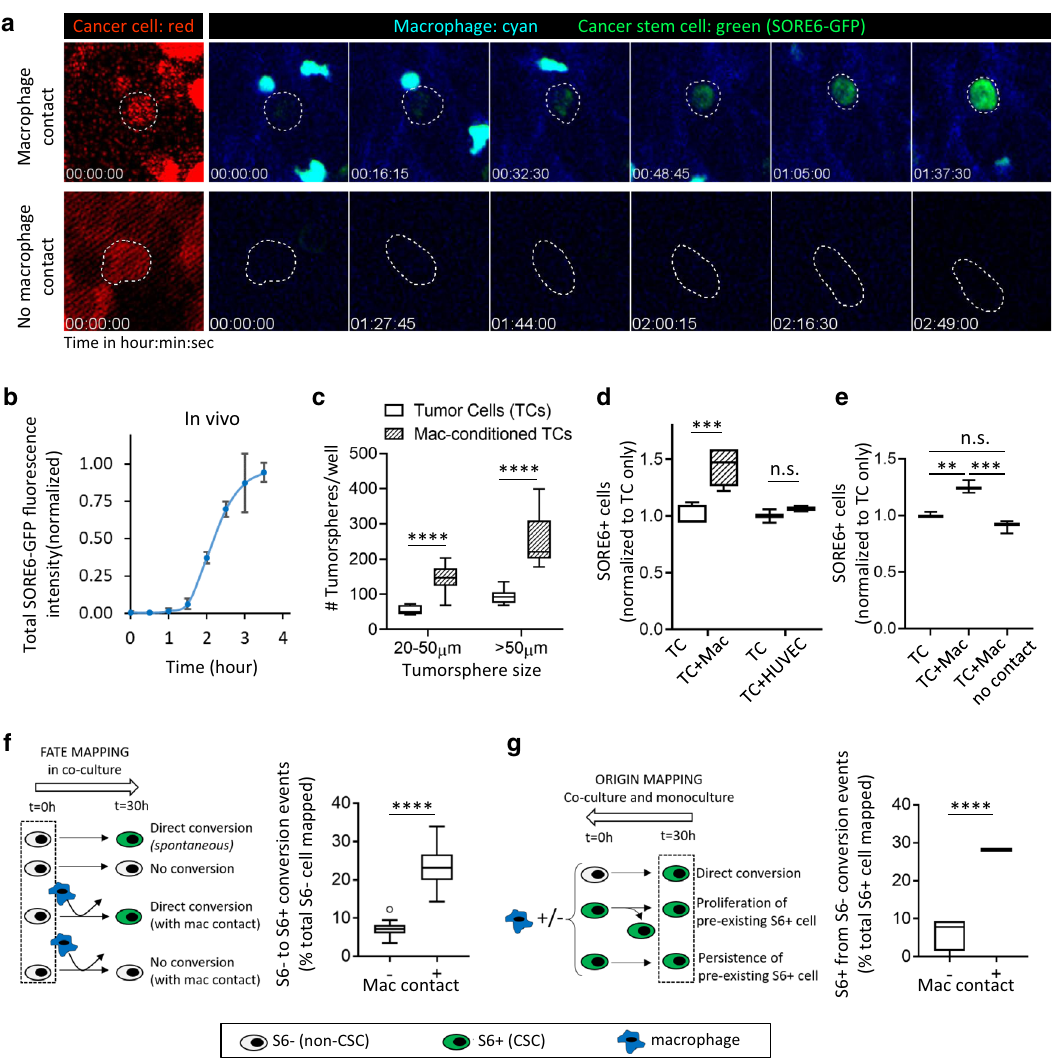
Fig. 4 Macrophage contact induces stemness in breast cancer cells. a Upper panels show SORE6>GFP induction (green) in vivo in a tumor cell after macrophage contact (Supplementary Movie 10). Lower panels show lack of stemness induction (no SORE6-GFP increase) in a tumor cell, which is not contacted by a macrophage. White dotted lines show tumor cell outlines, drawn based on the tdTomato volume marker (left panel). b Quanti fi cation of total SORE6-GFP fl uorescence intensity during stemness induction in tumor cells in vivo. Time 0 corresponds to the time when macrophage contacts the tumor cell. n > 200 cells analyzed from 10 mice, to identify tumor cells contacting macrophages and showing induced stemness, each data point plotted as mean ± SD. Data normalized to SORE6-GFP value before macrophage contact to set the 0 background and max SORE6-GFP value as 1 after macrophage contact. c Tumorsphere-forming activity of MDA-MB-231 cells with or without prior co-culture with BAC cells for 24 h. Multiple unpaired two-sided t -tests for each size class, n = 6 (TCs), n = 12 (MAC-conditioned TCs), **** p < 0.0001. d In vitro co-culture assay of tumor cells with or without macrophages or endothelial cells. Tumor cells were co-cultured with macrophages or endothelial cells overnight before the measurements were made. TC: MDA-MB-231 tumor cells, Mac: BAC1.2F5 macrophages. n = 120 fi elds (TC + Mac) and 40 fi elds (TC + HUVEC) at ×20 magni fi cation; unpaired two-tailed Student ’ s t - test, *** p = 0.0001, n.s. p = 0.4226. e MDA-MB-231-LM2 cells (TC) were co-cultured with BAC1.2F5 cells (Mac) for 36 h without or with a 3 µ m pore insert to separate the cell populations and assessed for the number of SORE6 + cells by fl ow cytometry. Two-sided Tukey ’ s multiple comparisons test, n = 3; *** p -values = 0.0013, n.s. = 0.0919, *** p = 0.0002. f Left: schematic showing the TC + Mac co-culture experimental setup and quanti fi cation procedure for the fate mapping of non-CSCs (S6 − ) in time-lapse movies. Right: quanti fi cation of SORE6 induction without or with macrophage contact in TC + Mac co-culture assay. Unpaired two-tailed Student ’ s t -test, n = 113 S6 − cells from 28 fi elds of 330 × 330 µ m 2 , **** p < 0.0001. g Left: schematic showing the TC alone or TC + Mac co-culture experimental setup and quanti fi cation procedure for the origin mapping of CSCs (S6 + ) in time-lapse movies. Right: quanti fi cation of SORE6 induction in TC alone ( − ) or TC + Mac ( + ) co-culture assay, respectively. Unpaired two-tailed Student ’ s t -test, n = 4 wells/ condition for a total of 128 cells traced/condition, **** p < 0.0001. c – g The boxes indicate 25th – 75th percentile interquartile range (IQR) and central line indicates the median. Top and bottom whiskers were plotted using Tukey ’ s method and extend to 75th percentile + 1.5 × IQR and 25th percentile − 1.5 × IQR, respectively. Points below and above the whiskers are drawn as individual